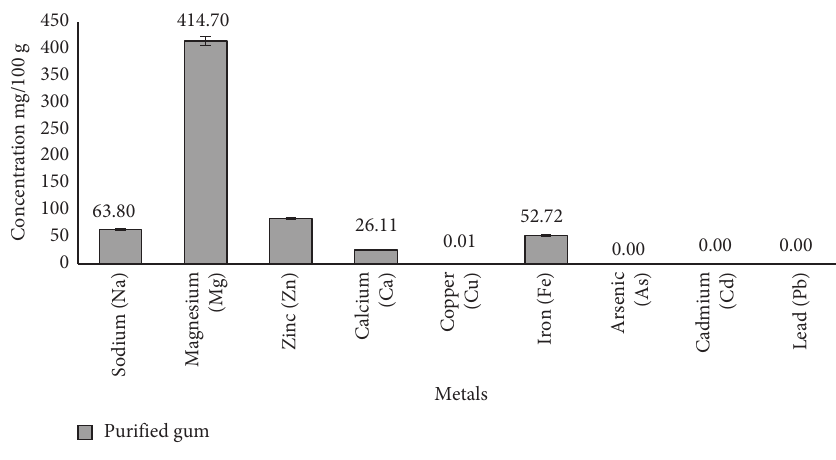
Figure 6: Mineral analysis of purified Khaya senegalensis gum. Table 3: Microbial quality of purified